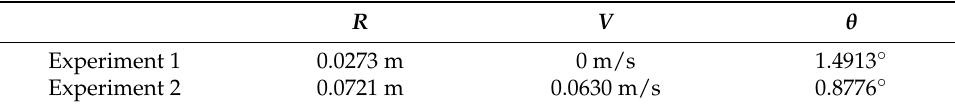
Table 5. The calculated RMSE for actual experiments.